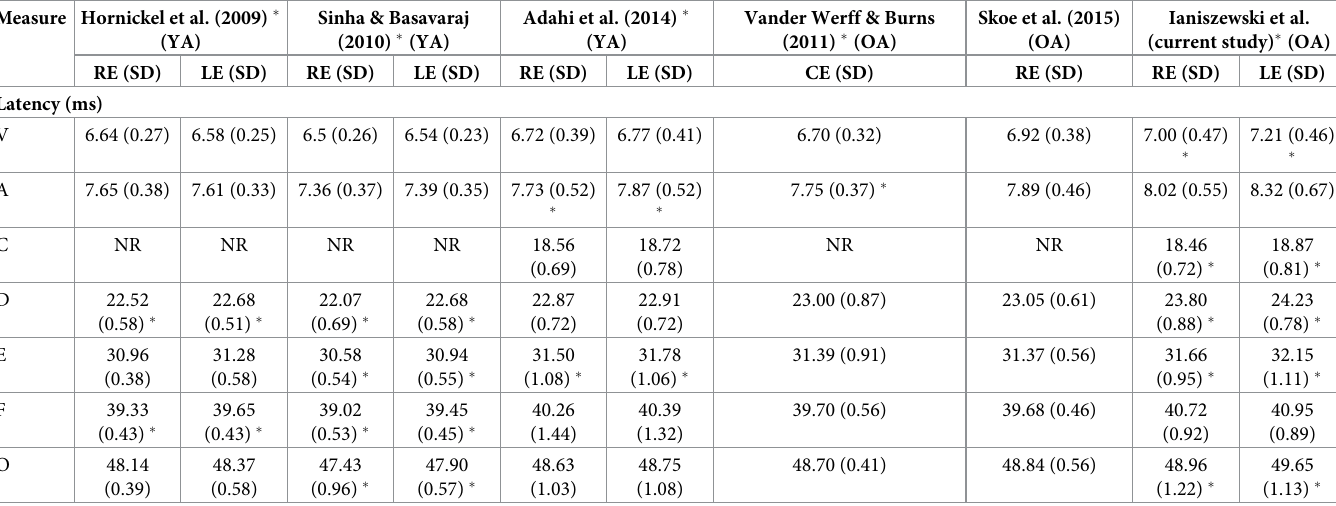
YA = Young adults; OA = Older adults; RE = Right ear; LE = Left ear; CE = Combined ears, NR = Not reported. � denotes studies and specific peaks where evidence of significant brainstem asymmetries between right and left ear presentation for speech-ABR have been found.